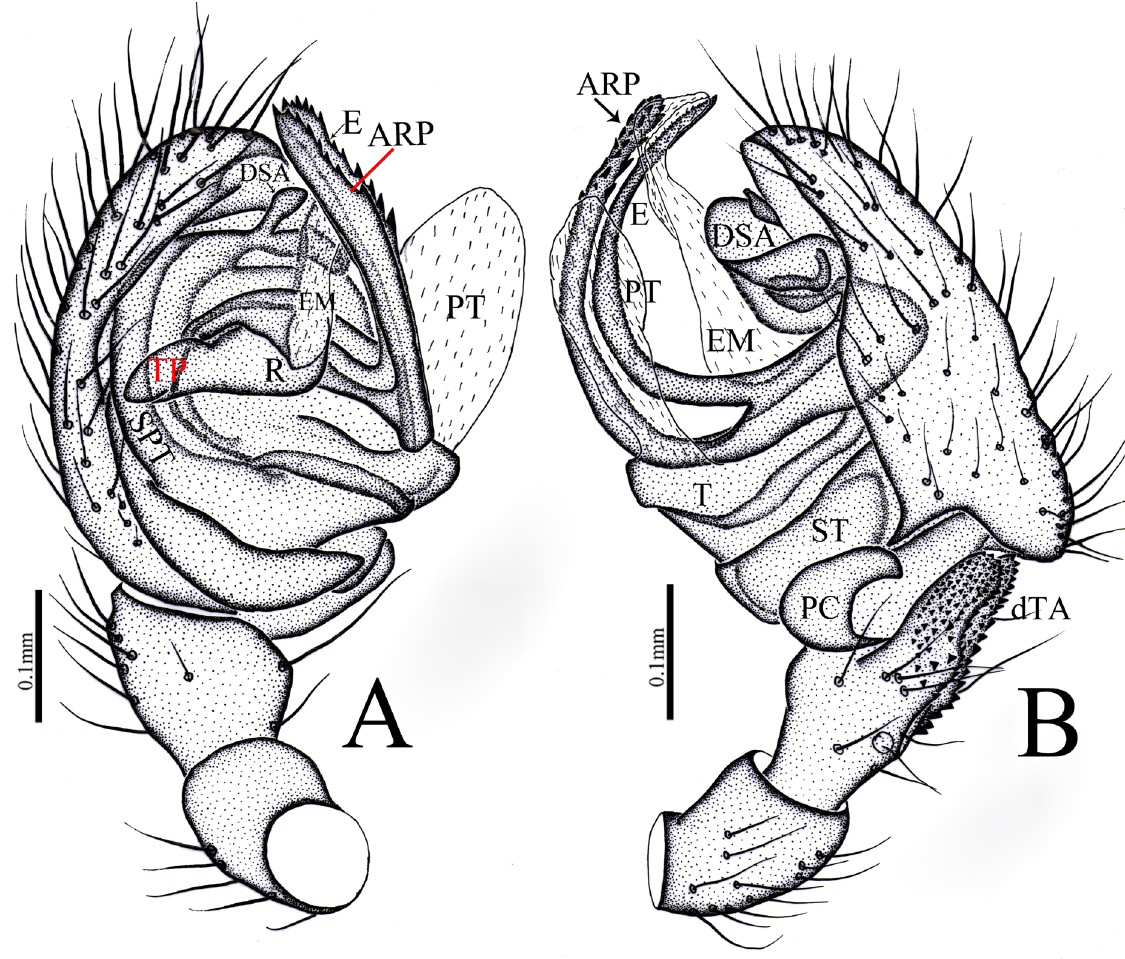
Fig. 7. Yuelushannus barbatus sp. nov., male palp, holotype (HNU-YLS-17-0301~01). A . Prolateral view. B . Retrolateral view. Scale bars: 0.1